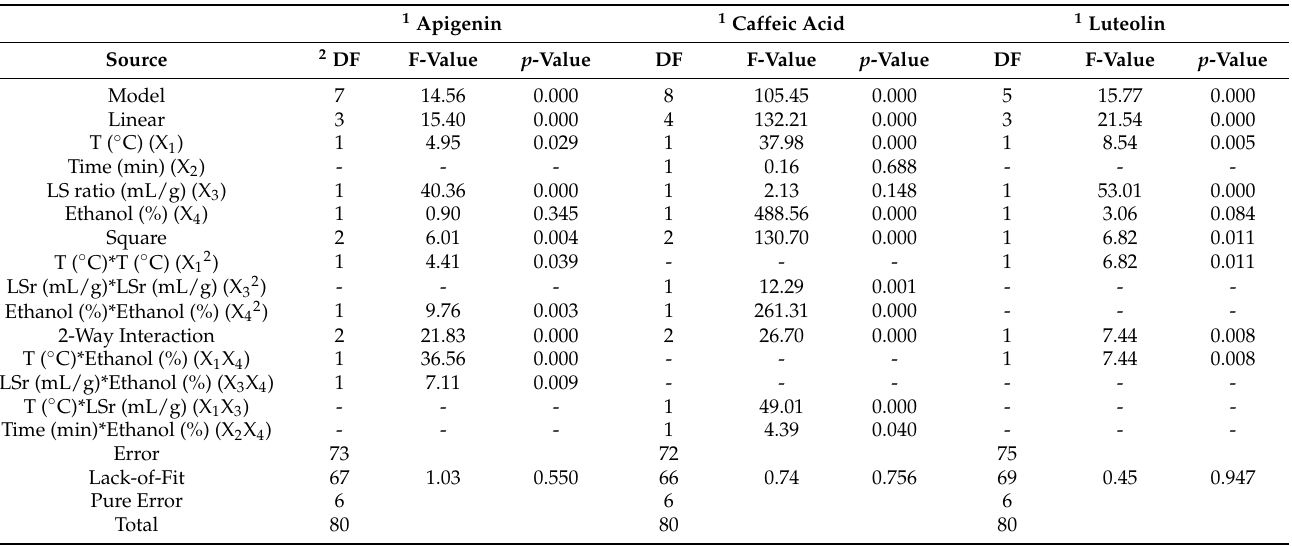
Table 3. Results of the analysis of the variance (ANOVA) for transformed data concerning the fitting of reduced response surface model for USE extraction of apigenin, caffeic acid, and luteolin. 1